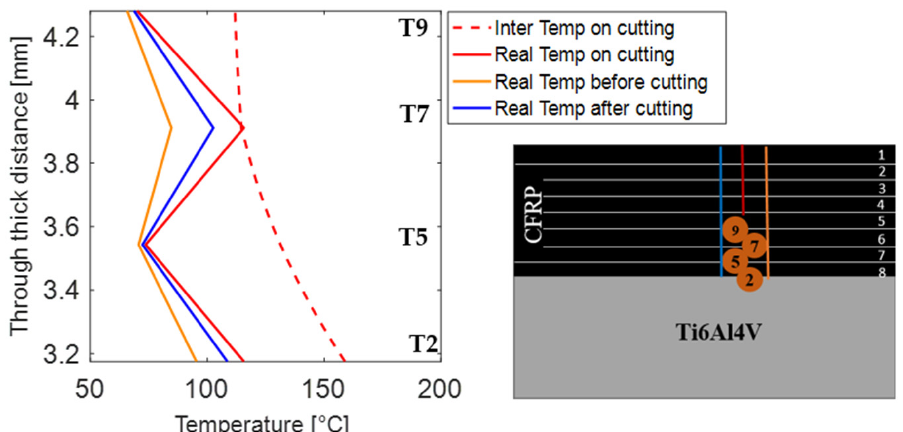
Figure 12. The temperatures T/C 2-5-7-9 along with the thickness for the [0]8/Ti6Al4V stack using tool3, v of 175 m/min, ft of 0.05 mm/tooth and ae of 1 mm.